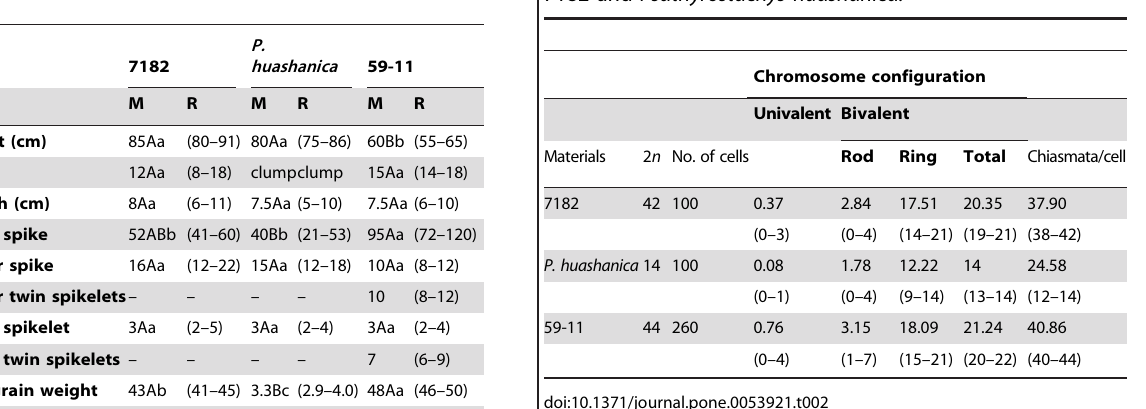
Table 2. Chromosome pairing at metaphase I in PMCs